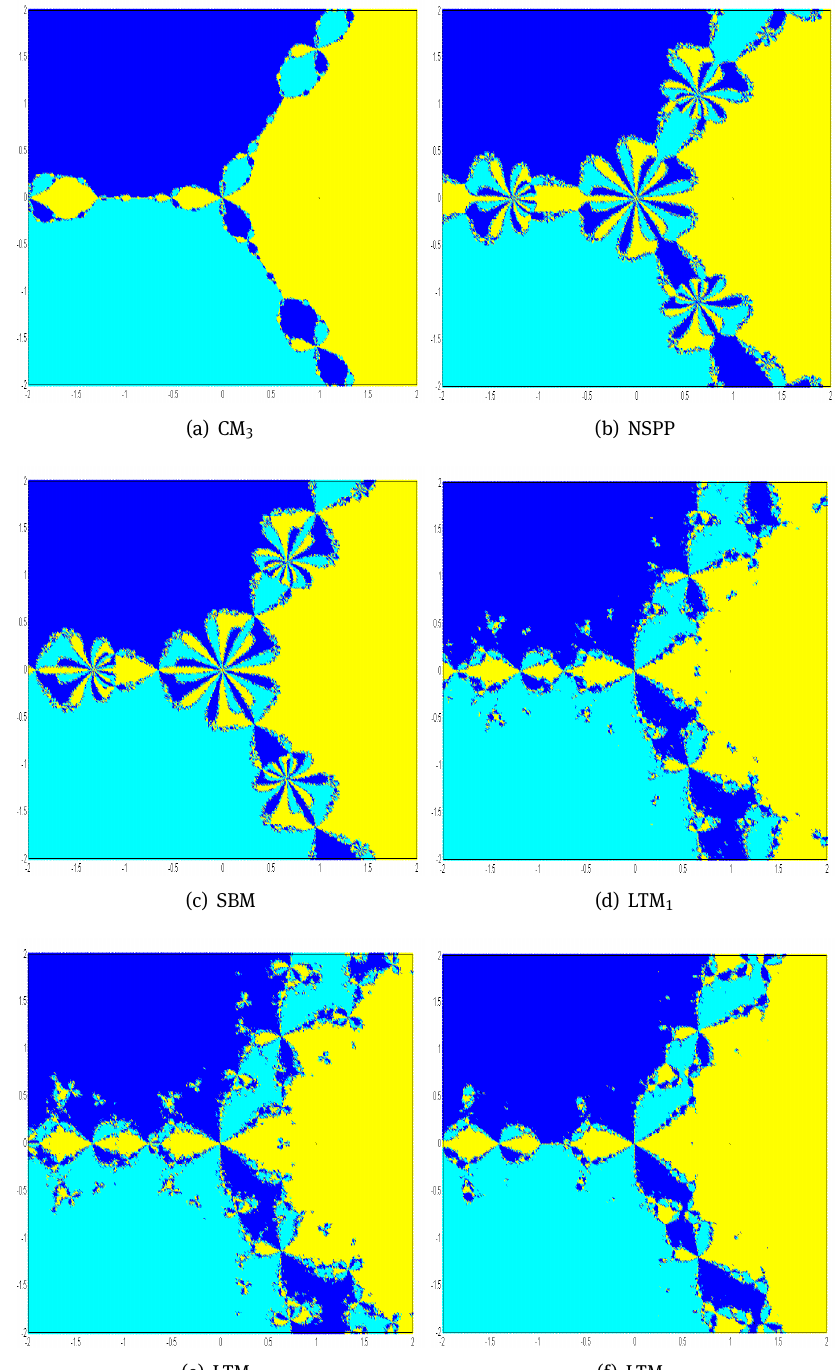
Figure 2: Basins of attraction of the methods CM 3 , NSPP, SBM, LTM 1 , LTM 2 and LTM 3 respectively for P 1 ( z ) = z 3 − 1